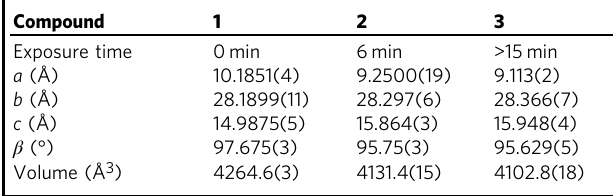
Table 1 Summary of unit cell parameters of framework 1 and frameworks 2 and 3 obtained upon